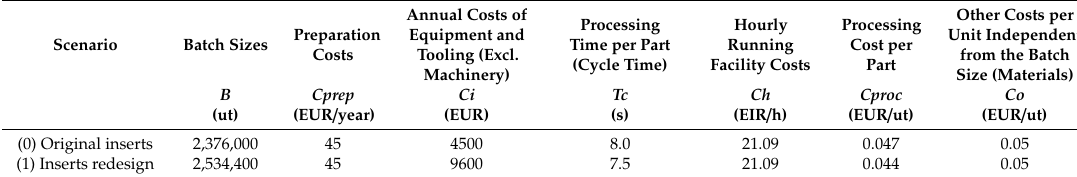
Table 6. Main parameters for the unit cost comparison for the scenarios of the initial insert designs (without cooling channels) and the redesigns (with cooling